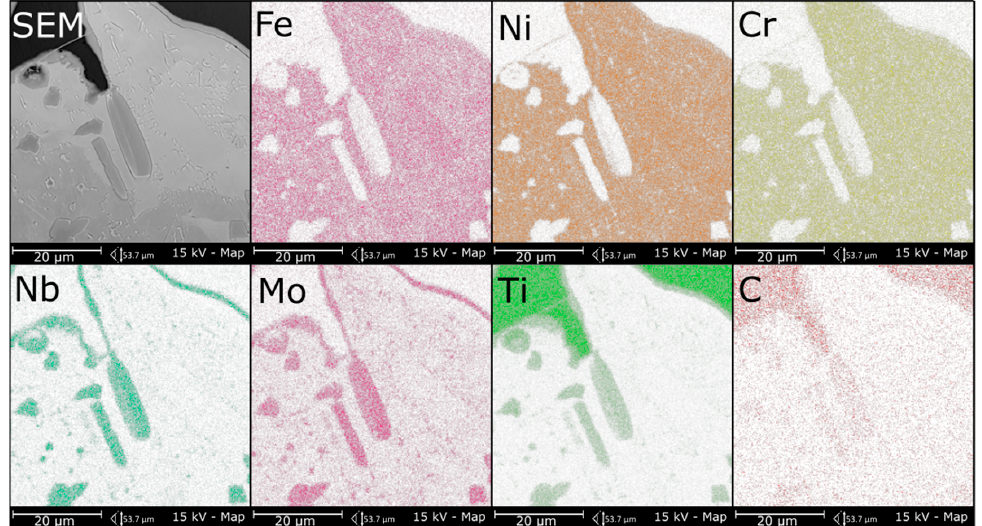
Figure 10. The EDS analysis results of the overlap area, representative